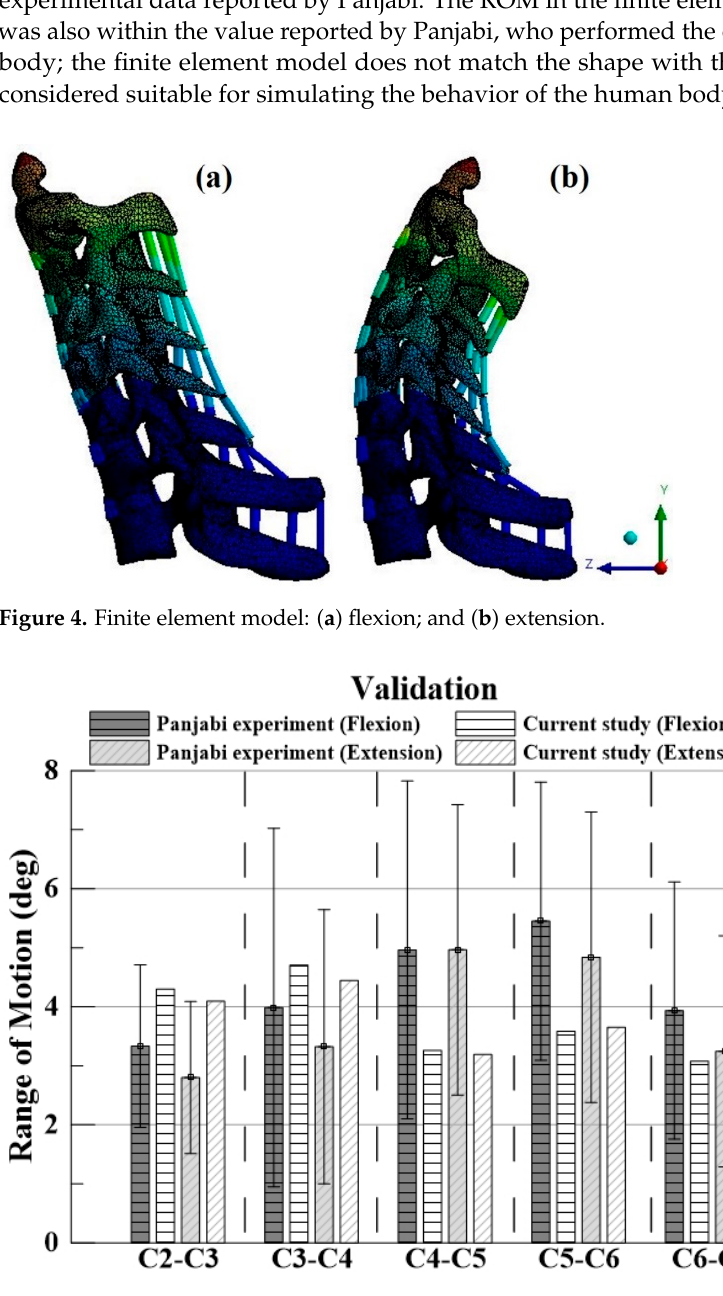
Figure 5. Validation based on Panjabi’s experimental data.